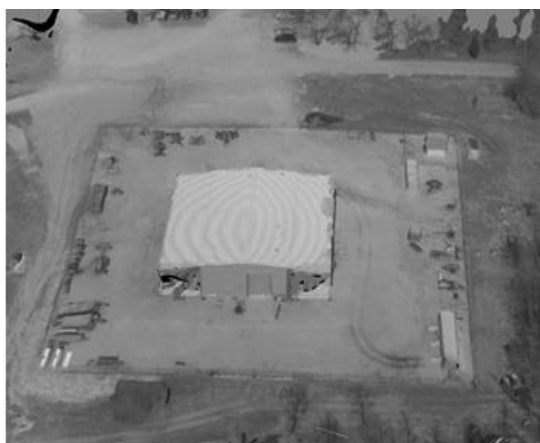
Figure 9. Textured 3D model created by Agisoft PhotoScan from single circular flight over machine storage area using the NGA quadcopter with a GoPro flat lens camera Figure 7 is another dense point cloud built from 117 photos taken with the GoPro in a single circular orbit around a machine storage area.